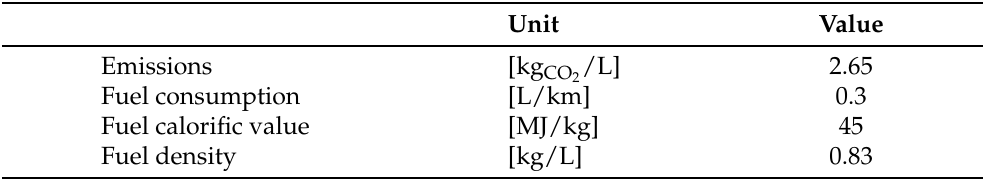
Table 2. Impact evaluation data of a diesel powered IVECO ECOSTRALIS Active AS truck considering a payload of 10,200 kg.